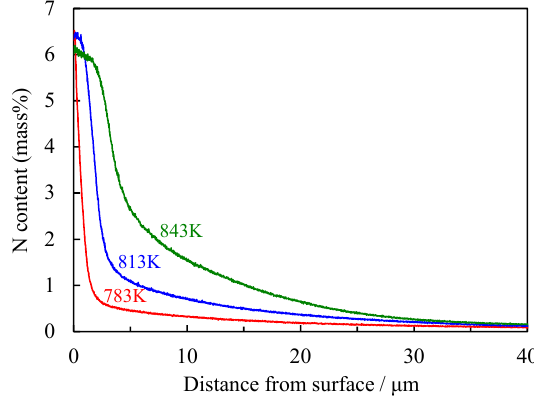
Figure 5. GDS analysis of ASPN-treated plate samples.